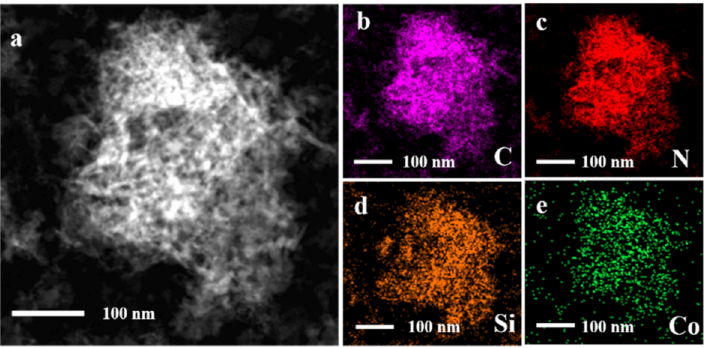
Figure 1. ( a ) TEM image of Co-N-Si/AC and ( b – e ) the corresponding elemental mapping of C, N, Si and Co,